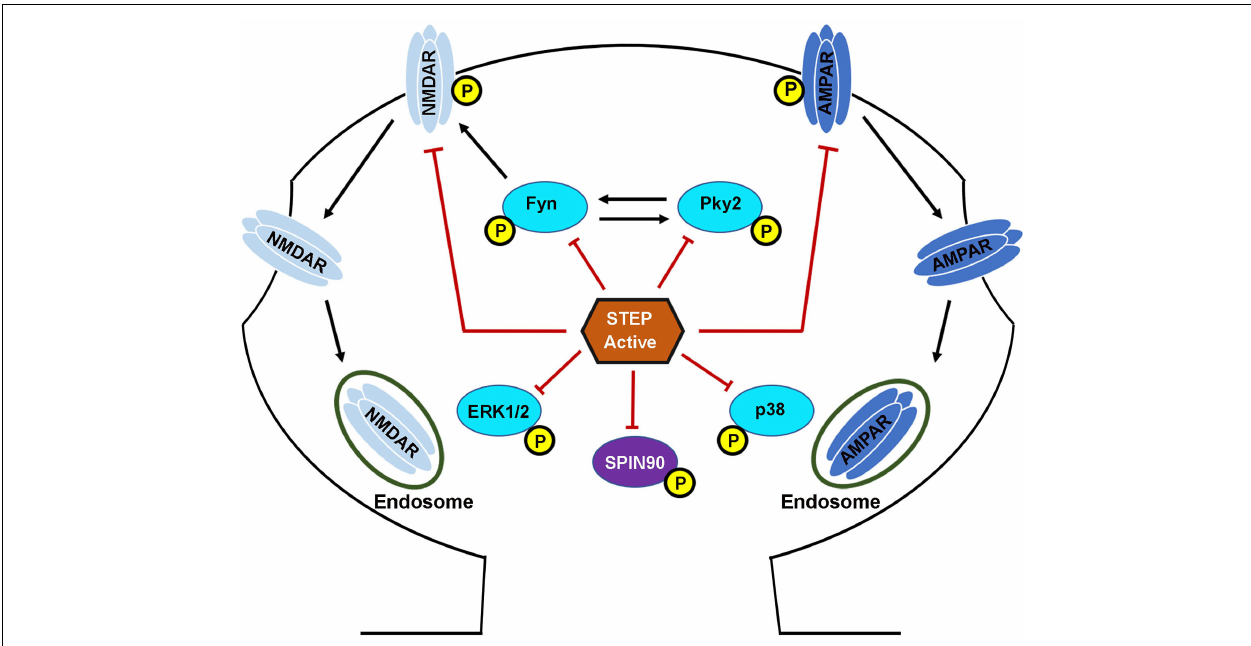
FIGURE 3 | STriatal-enriched protein tyrosine phosphatase substrates. Following the NMDAR or α 7nAChR stimulation mediated activation, STEP can then bind and dephosphorylate regulatory tyrosines within its substrates. The dephosphorylation of STEP substrates including GluN2B, GluA2\GluA3, Fyn, Pyk2, ERK1/2, p38 and SPIN90 leads to their inactivation. The dephosphorylation of GluN2B and GluA2\GluA3 subunits of NMDARs and AMPARs, respectively, results in internalization from the PSD. The dephosphorylation of Fyn, Pyk2, ERK1/2, and p38 leads to inhibition of their kinase activity and impairment of the downstream effects. The dephosphorylation of SPIN90 leads to its translocation to the dendritic shaft causing the release of its binding partner cofilin. STEP dephosphorylates GluN2B subunit of NMDARs by two mechanisms. First, STEP can directly dephosphorylate GluN2B at Tyr1472. Secondly, STEP can indirectly mediate the dephosphorylation of GluN2B via the inactivation of Fyn, the kinase that phosphorylates GluN2B at the same Tyr1472. The net result is endocytosis of GluN2B-containing NMDARs. STEP can also mediate the endocytosis of AMPARs via direct dephosphorylation of GluA2 and GluA3 subunits of these